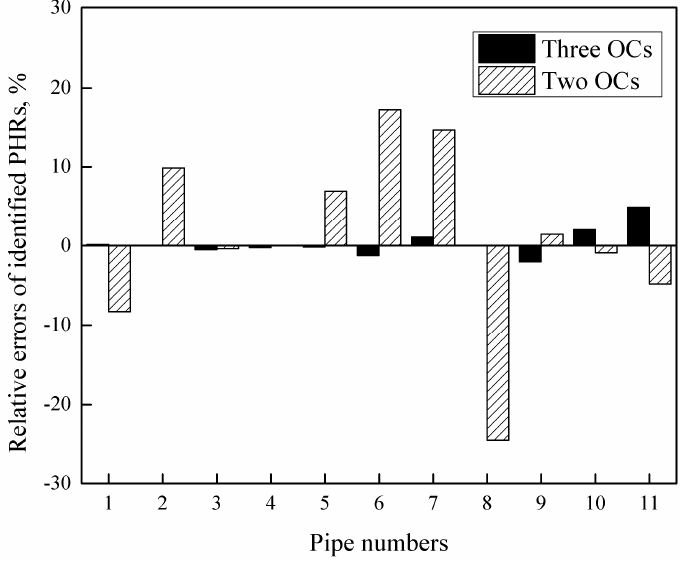
Figure 2. Relative errors of pipe hydraulic resistances (PHRs) identification results (error range = 1%).